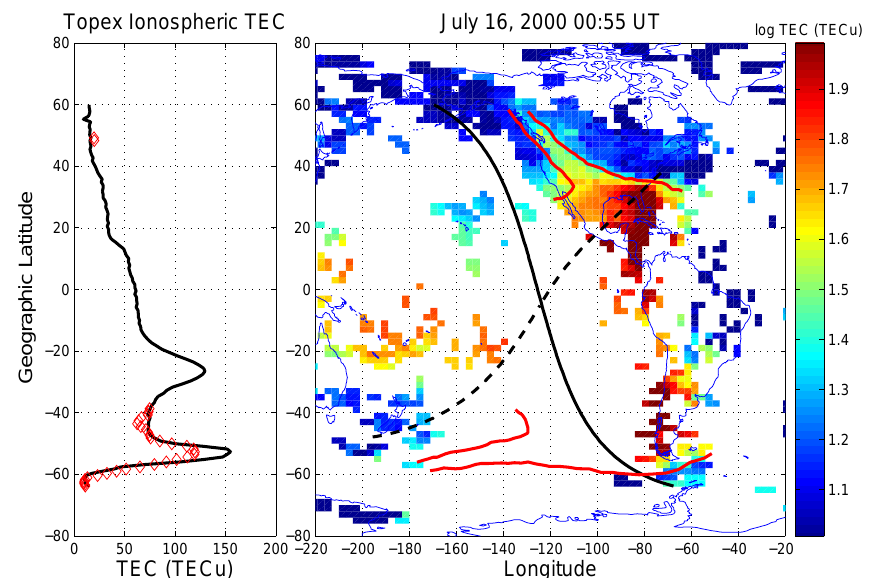
Fig. 1. Right: A 20-min snapshot of log GPS TEC is shown. The heavy black line denotes the N to S orbital track of the TOPEX satellite and the heavy dashed line indicates the magnetic conjugate orbit. Red lines outline the boundaries of the SED plume and its conjugate location. Left: TOPEX vertical TEC (heavy black line) is shown as a function of latitude. Values of GPS TEC observed along the conjugate TOPEX orbit are plotted point by point (red diamonds) at their corresponding conjugate latitudes, on top of the direct TOPEX TEC observations.